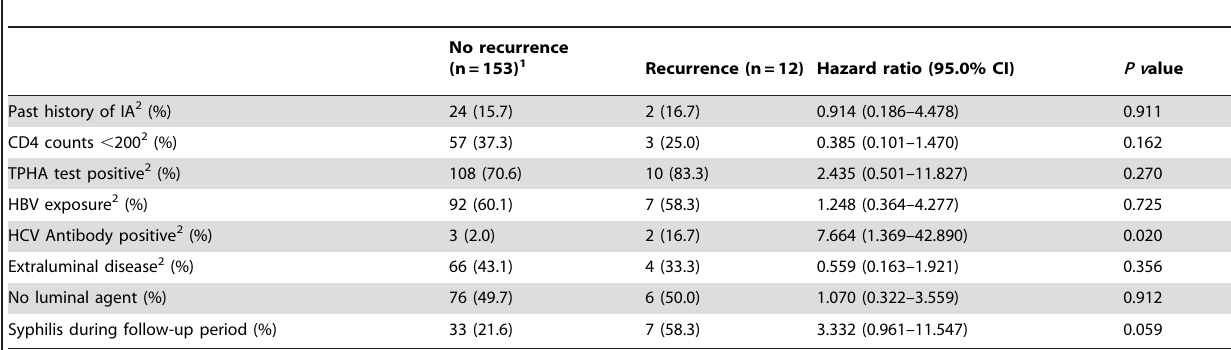
Table 3. Multivariate analyses for factors associated with frequency of